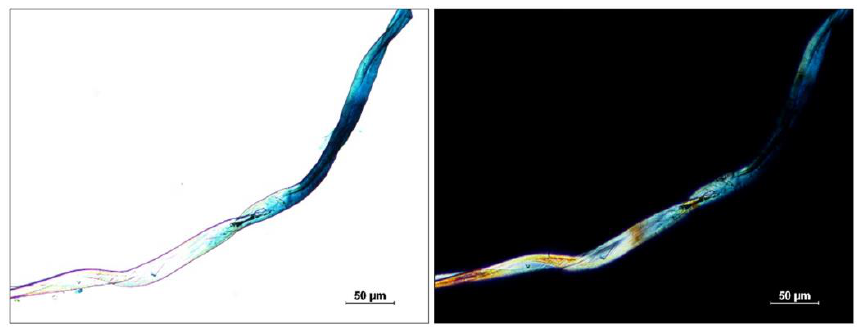
Figure 4. Typical uneven dyeing of cotton fibre retrieved from blue denim fabric in transmitted white ( left image ) and polarized ( right image ) light.